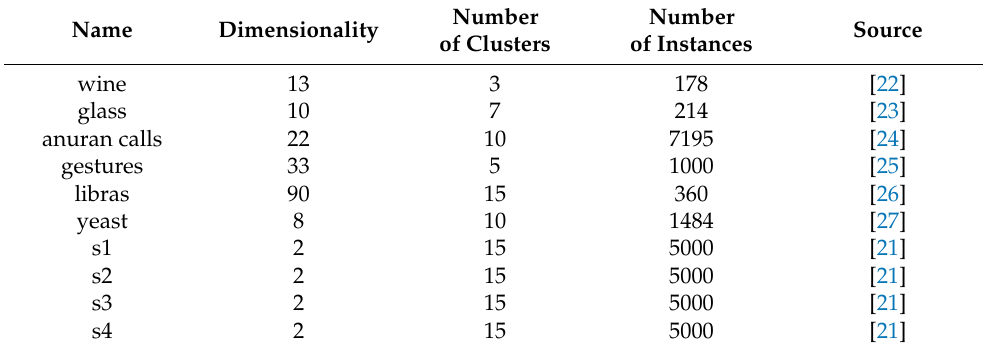
Table 1. Datasets used in the experiments.